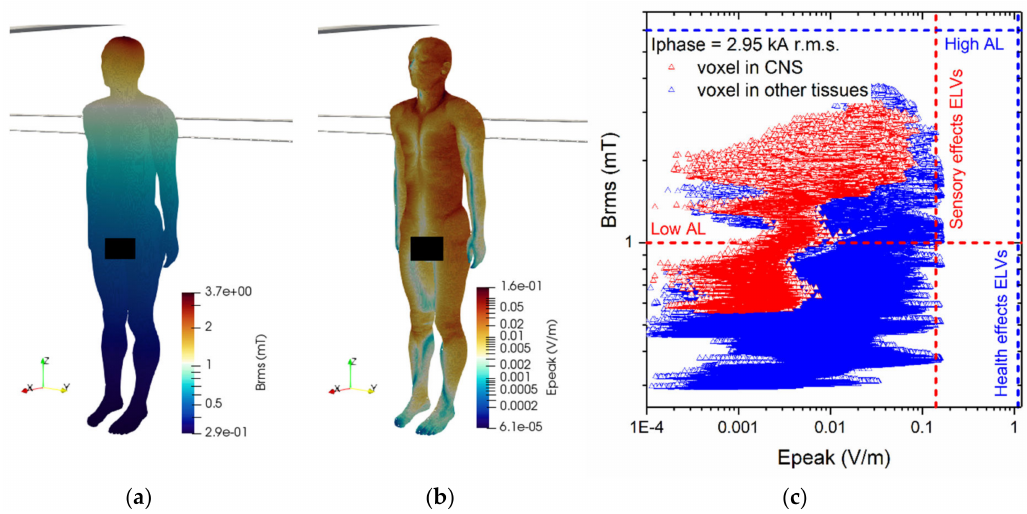
Figure 8. Results for posture A.3. On the left ( a ) the spatial distribution of the B-field amplitude (r.m.s. values in millitesla) over the body surface. In the middle ( b ) the corresponding spatial distribution of the E-field amplitude (peak values in volt per metre) over the body surface. On the right ( c ) the distribution of the voxel values.